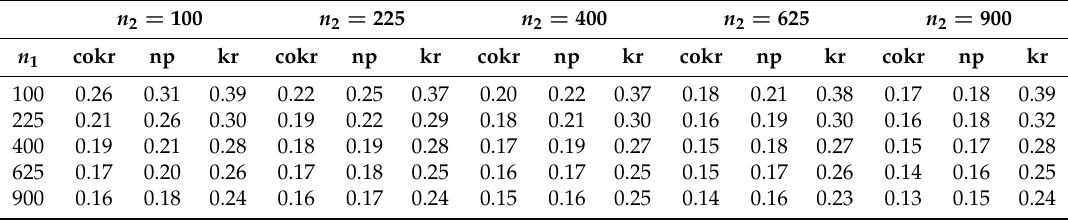
Table 2. AMSPE values obtained for several sample sizes n 1 and n 2 and correlation ρ 12 ( 0 ) = 0.99, for data drawn from random fields Z 1 and Z 2 with constant trends, derived from Gaussian processes V 1 and V 2 with nugget and spherical semivariograms, respectively. For implementation of the kriging and cokriging approaches, the dependence structures of V 1 and V 2 were estimated through the theoretical